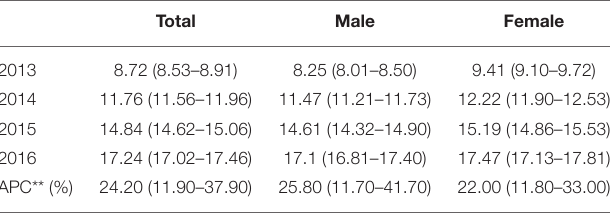
TABLE 2 | Annual age-standardized prevalence rate of ulcerative colitis among urban employees in 23 provinces (municipalities, autonomous regions) of China from 2013 to 2016 (per 100,000 persons) *